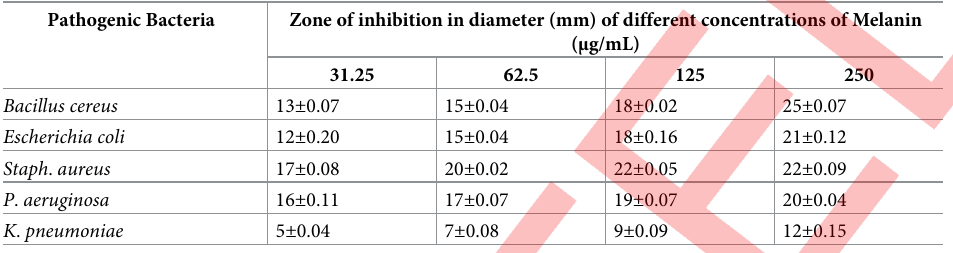
Values are the average of triplicates. ± indicates standard